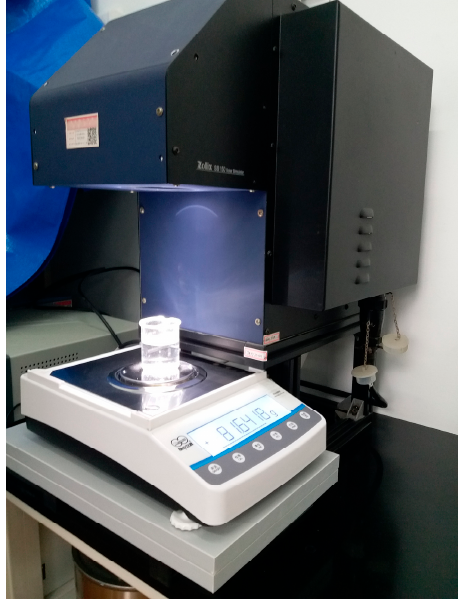
Figure 3. Experimental system.